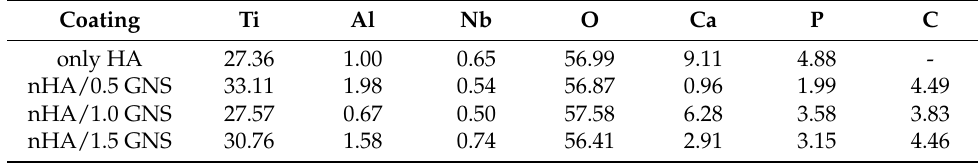
Table 2. EDS analysis results of nHA/GNS coated Ti6Al7Nb alloys indicated in Figure 5 (at %). Coating Ti Al Nb O Ca P C only